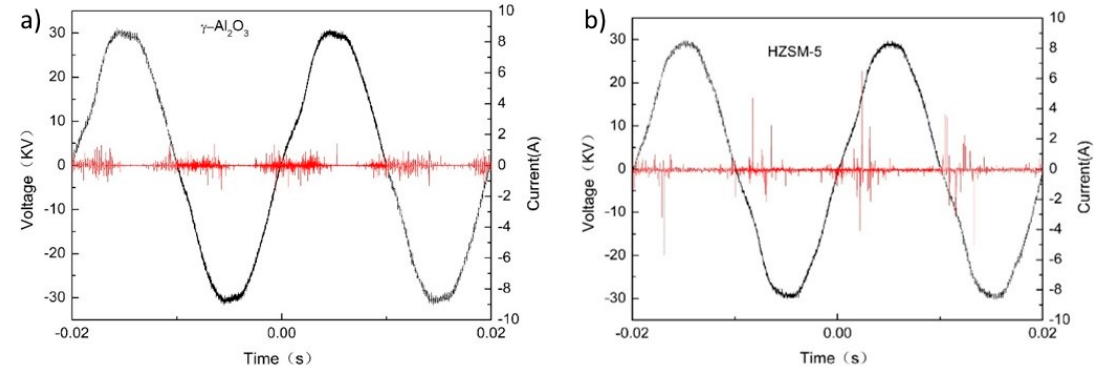
Figure 17. Voltage–current diagrams of ( a ) γ -Al 2 O 3 and a ( b ) HZSM-5 packed NTP reactor. Reprinted from Reference [100], with permission from Elsevier.